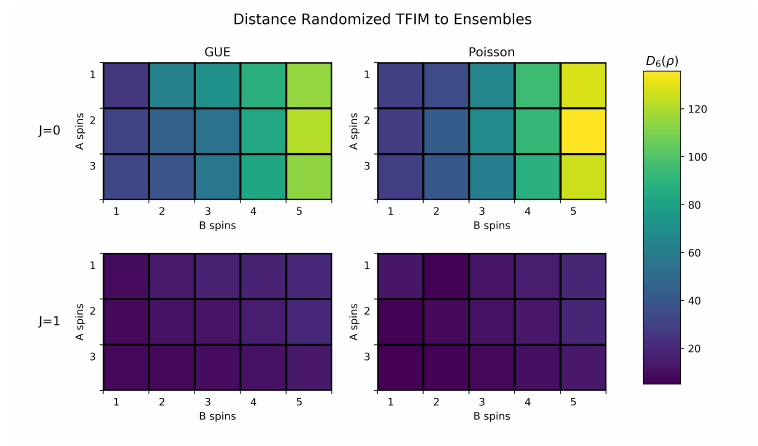
Figure 22: Left: Normalized distance of dynamics of Transverse Field Ising Model (see equa- tion 42) to analytical GUE. Right: to analytical Poisson.